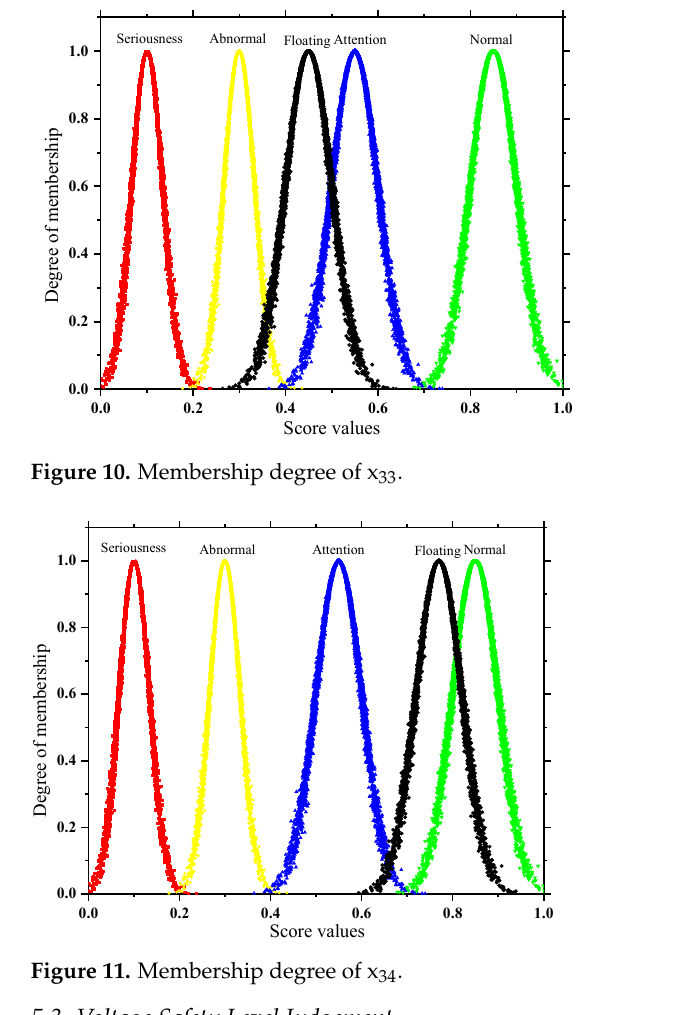
Figure 9. Membership degree of x 32.